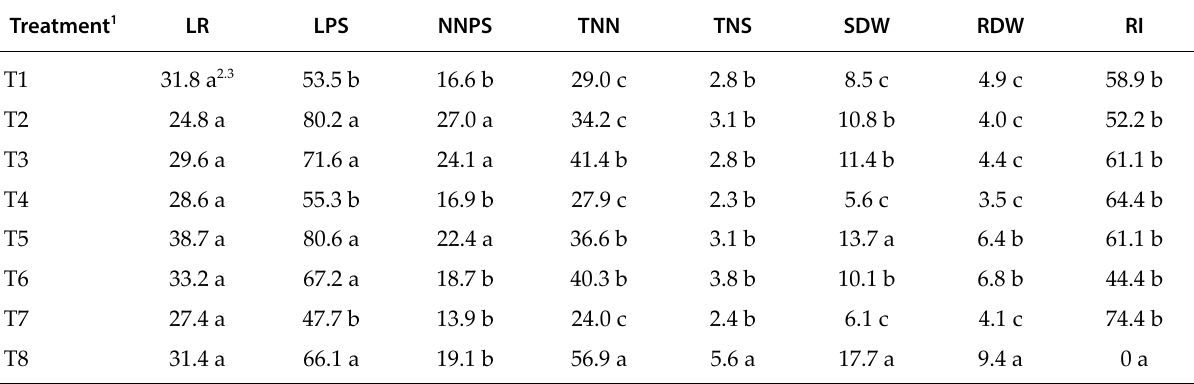
1 Treatment: T1, Trichoderma harzianum (Trichodermil SC1306 ® ); T2, Trichoderma asperellum (TrichoderMax EC ® ); T3, Trichoderma asperellum (Quality WG ® ); T4, Trichoderma harzianum , Trichoderma viride/atroviride and Trichoderma viride (Trichodel ® ); T5, Bacillus subtilis (Rizos ® ); T6, Bacillus subtilis (Rizolyptus ® ); T7, pathogen (positive control); T8, negative control. 2 Means within the column followed by the same are not different by the Scott-Knott test ( P ≤0.05). 3 Transformed data (√( x +